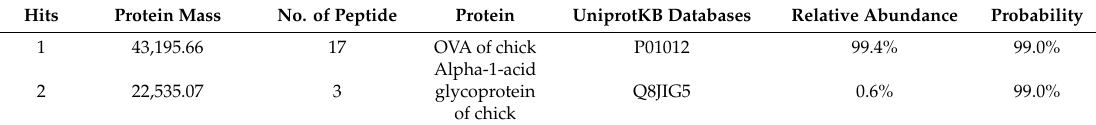
Table 5. Nano LC-ESI-MS / MS results of the OVA purified from top phase of ATPF.